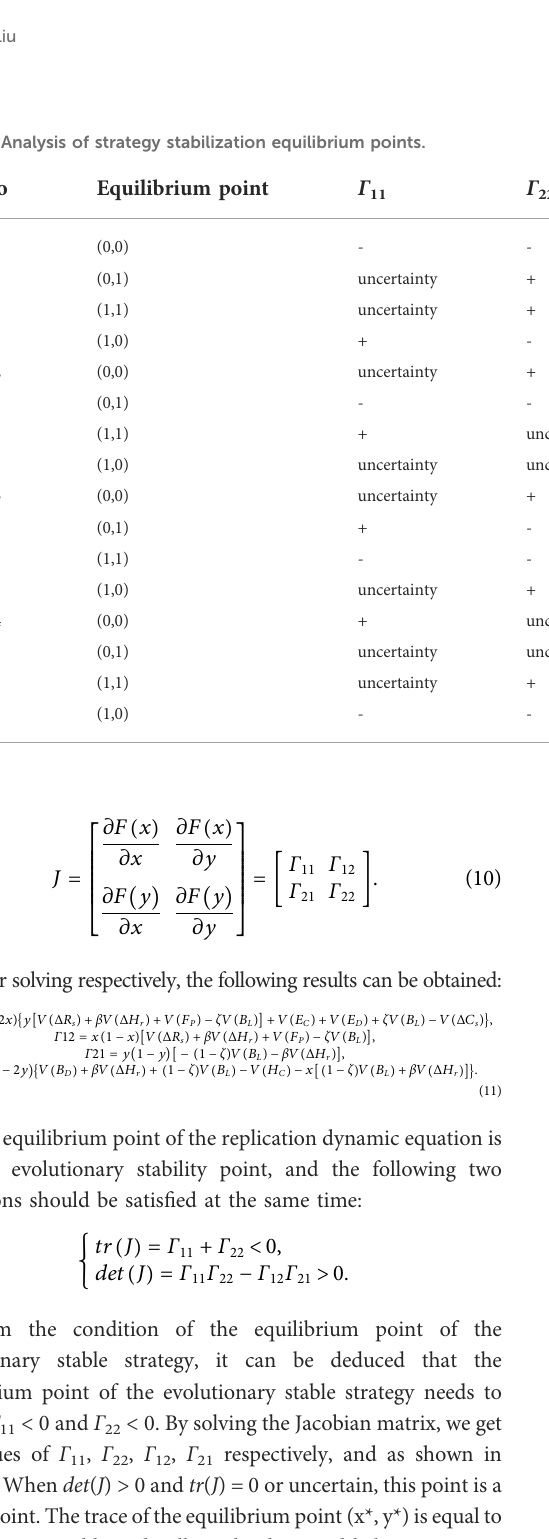
Table 2. When det ( J ) > 0 and tr ( J ) = 0 or uncertain, this point is a saddle point. The trace of the equilibrium point (x*, y*) is equal to 0, so it is not stable and will not be discussed below.